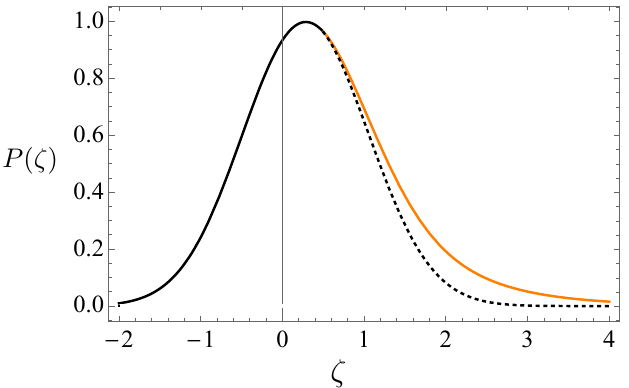
Figure 2 . Toy model of the distribution described in eqs. (4.35). The black region is the when ζ < σ 2 / ¯ κ while the orange line is otherwise. The dotted line is a Gaussian distribution that fits the ζ region in the left of the plot. The parameters are made up to highlight the fact that the distribution on the right has a very non Gaussian